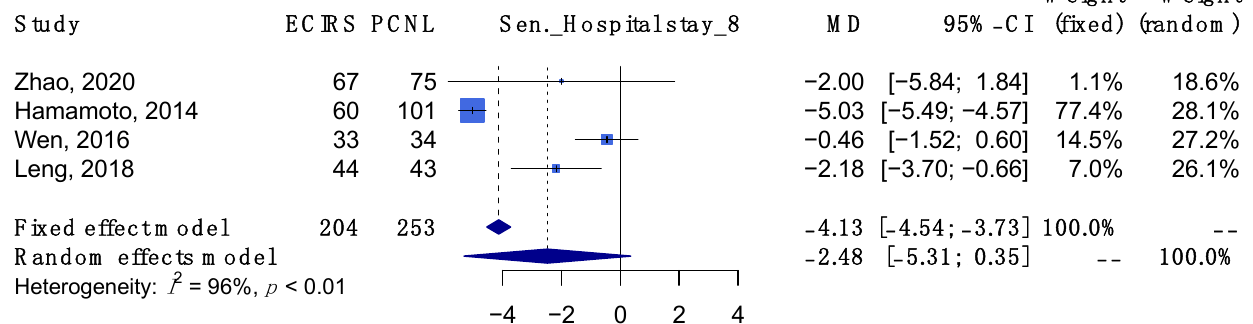
Figure A36. Sensitivity analysis of outcome regarding hospital stay. ([17–19,22])